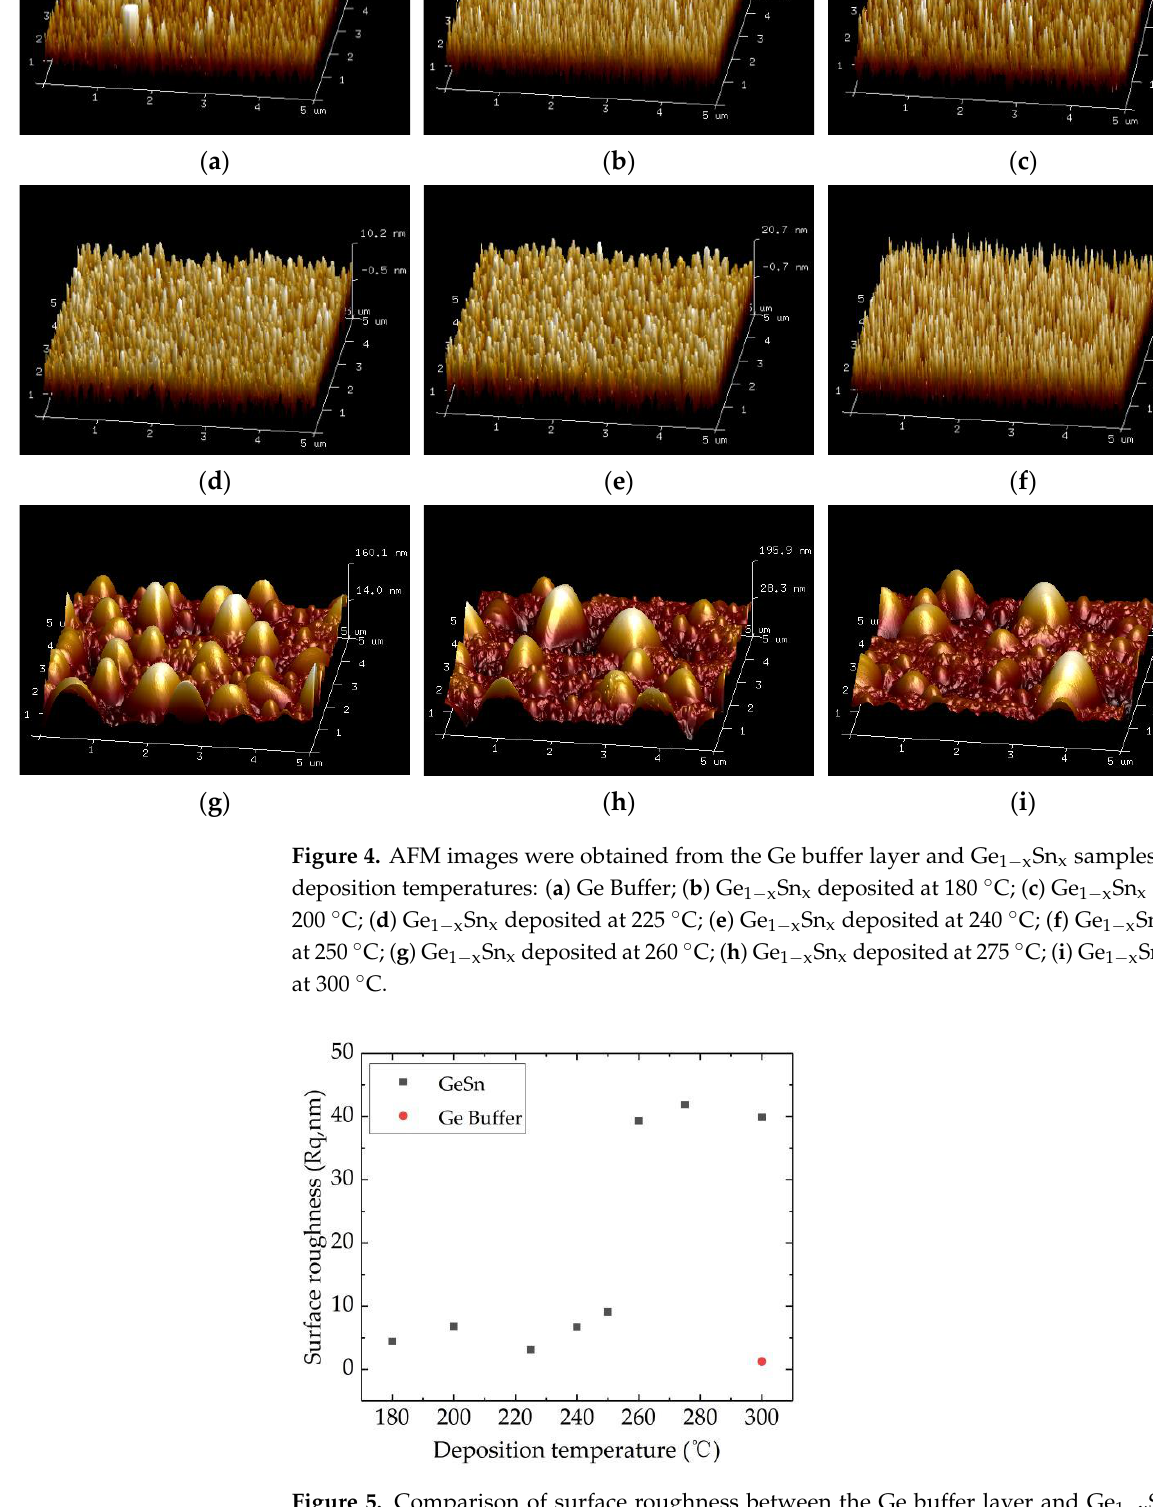
Figure 5. Comparison of surface roughness between the Ge buffer layer and Ge 1 − x Sn x samples deposited at different temperatures.